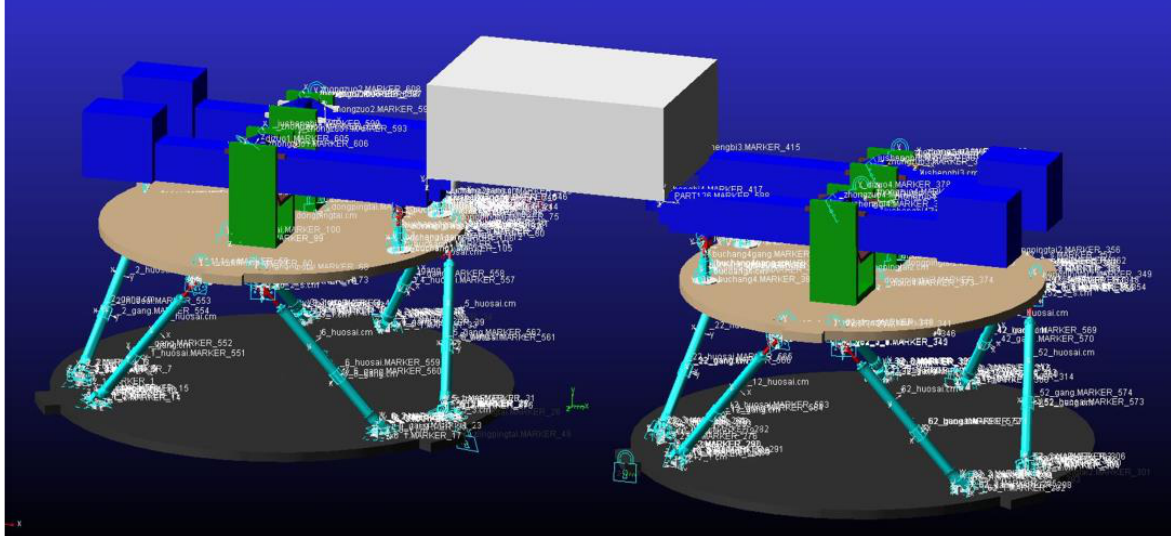
Figure 8. ADAMS model of the integrated dismantling equipment experimental platform.